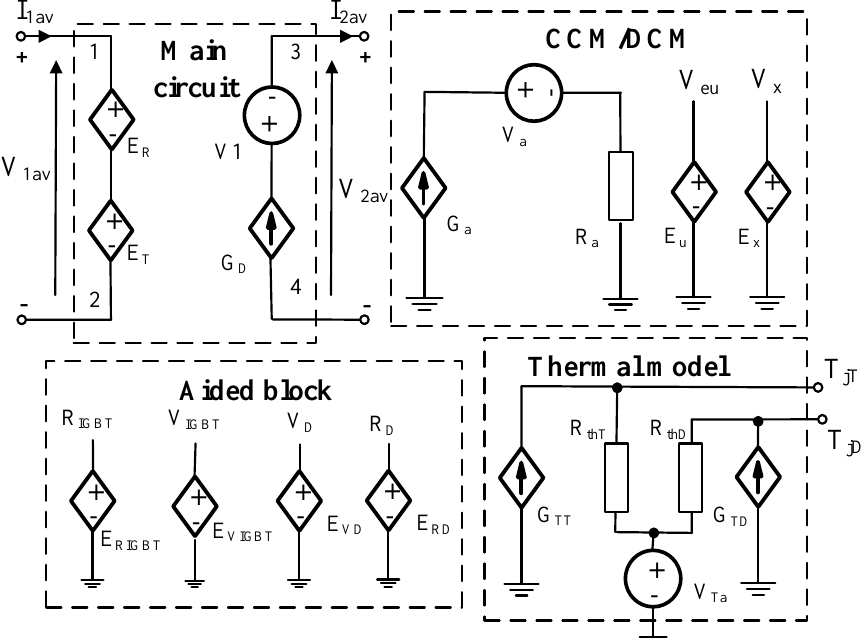
Figure 3. Network representation of the AVG model including the IGBT and the diode [32]. The described model contains four blocks: main circuit, aided block, thermal model, and CCM/DCM.